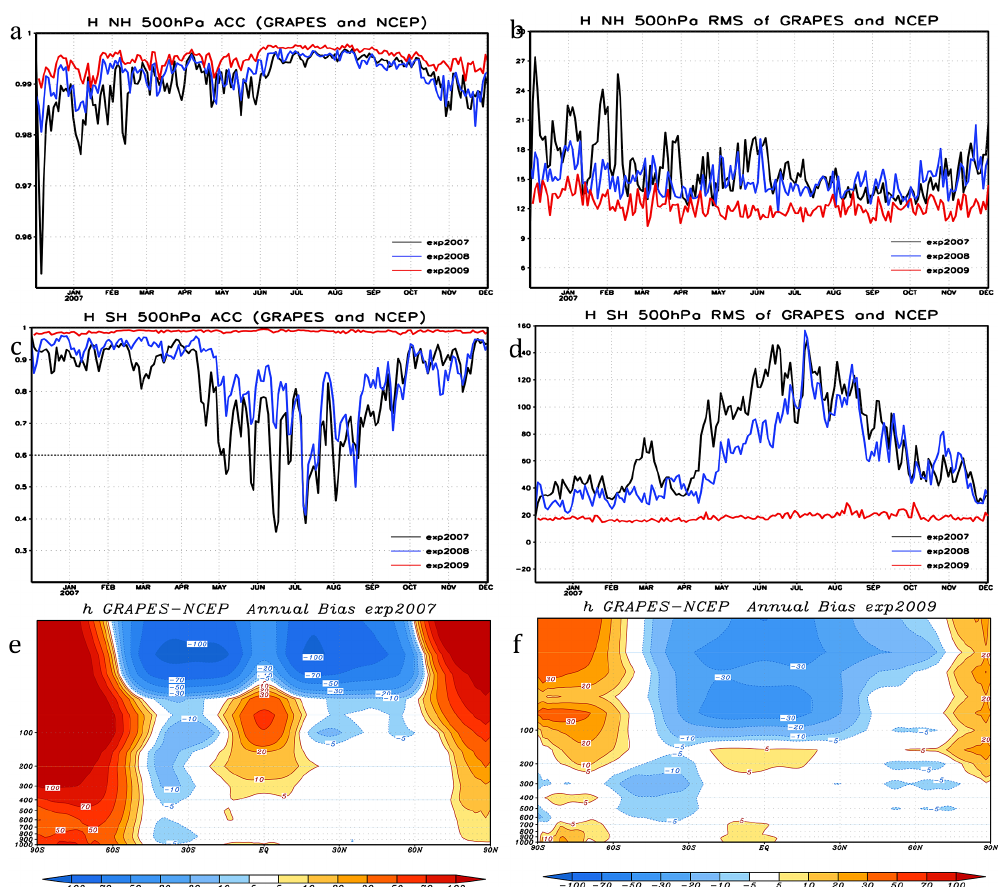
Figure 2. Geopotential height comparisons between the GRAPES and NCEP analyses. (a) is the 500mb correlation coefficient in the NH; (b) is the 500mb RMSE (GRAPES minus NCEP) in the NH; (c) is the same as (a) , except it is for the SH instead of the NH; (d) is the same as (b) , except it is for the SH instead of the NH. In (a–d) , the black, blue and red lines correspond to the experiments performed in 2007, 2008 and 2009, respectively; (e–f) are the latitude–pressure plots of the annual mean difference (GRAPES minus NCEP) for the experiments in 2007 and 2009,